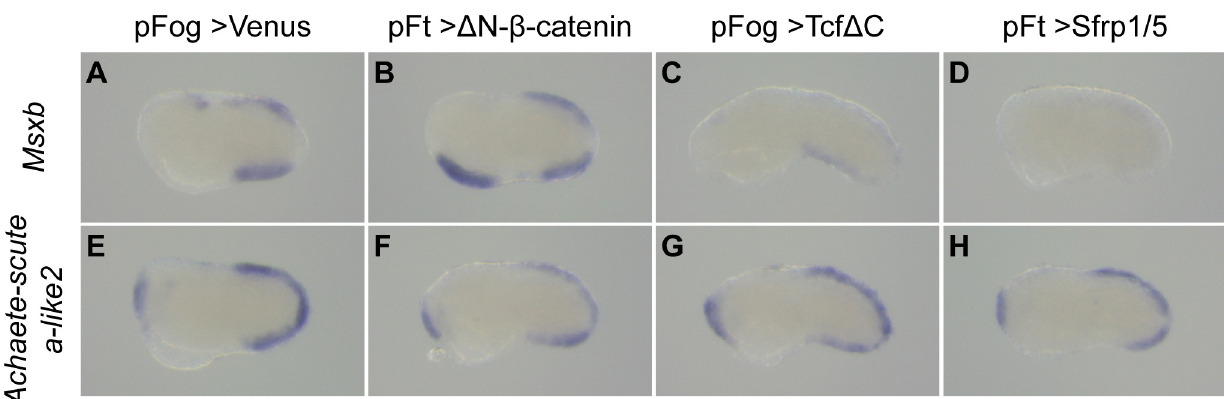
Fig 7. Differential regulation of tail PNS genes by Wnt signaling. Embryos were electroporated with pFog > Venus (A, E), pFt > Δ N- β -catenin (B, F), pFog > Tcf Δ C (C, G), and pFt > Sfrp1/5 (D, H), and fixed for in situ hybridization at initial tailbud stages (stage 18) for Msxb (A-D) and Achaete-scute a- like2 (E-H). Msxb is positively regulated by cWnt signaling: ectopic expression in the ventral trunk epidermis upon activation (B) and downregulation in dorsal and ventral tail neurogenic regions upon inhibition (C, D). By contrast, Achaete-scute a-like2 expression is unchanged for both cWnt activation or inhibition (F-H). Embryos are oriented with dorsal to the top and anterior to the left. Number of experiments: one for Achaete-scute a-like2 and three or more for Msxb .